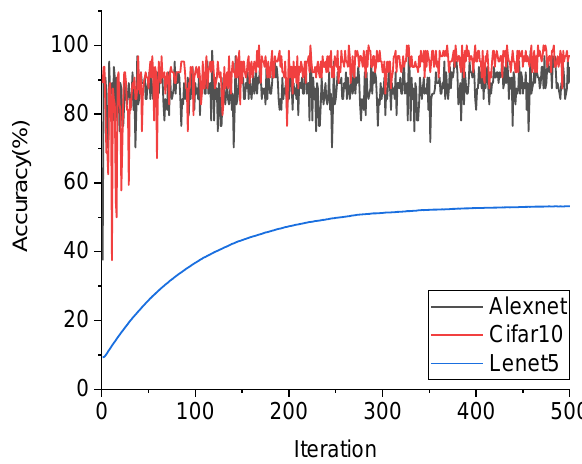
Figure 6. Accuracy variations during the training process using Alexnet, Lenet5, and CIFAR10, respectively.